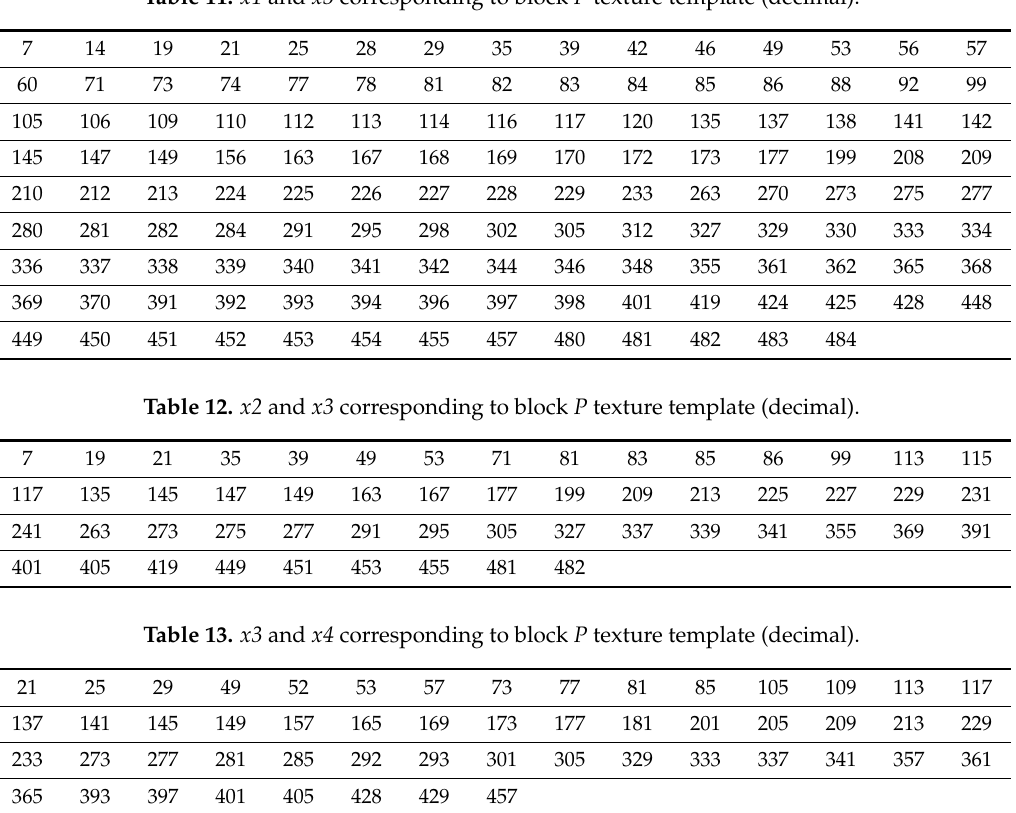
Table 11. x1 and x3 corresponding to block P texture template (decimal).